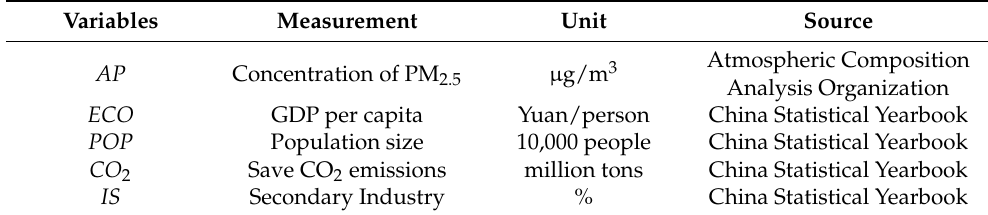
Table 2. Variable Measurements and Sources.